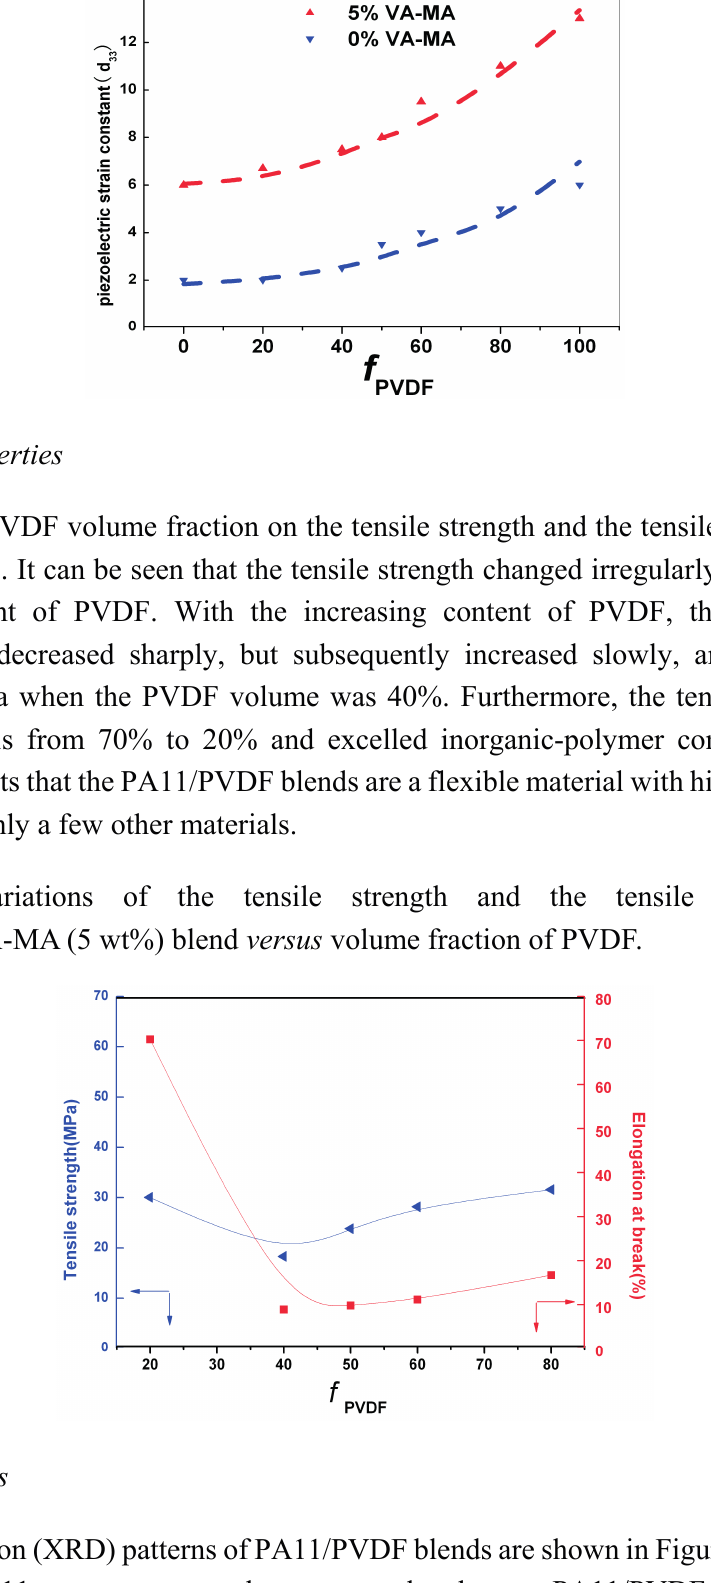
Figure 3. The piezoelectric constant d